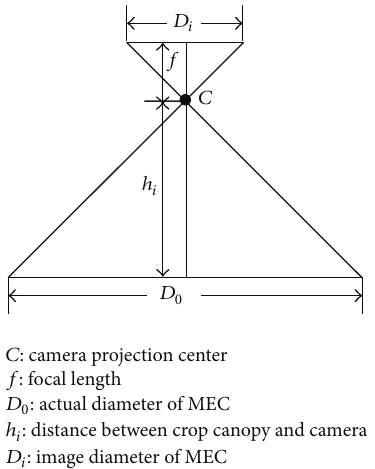
Figure 8: Imaging geometry of